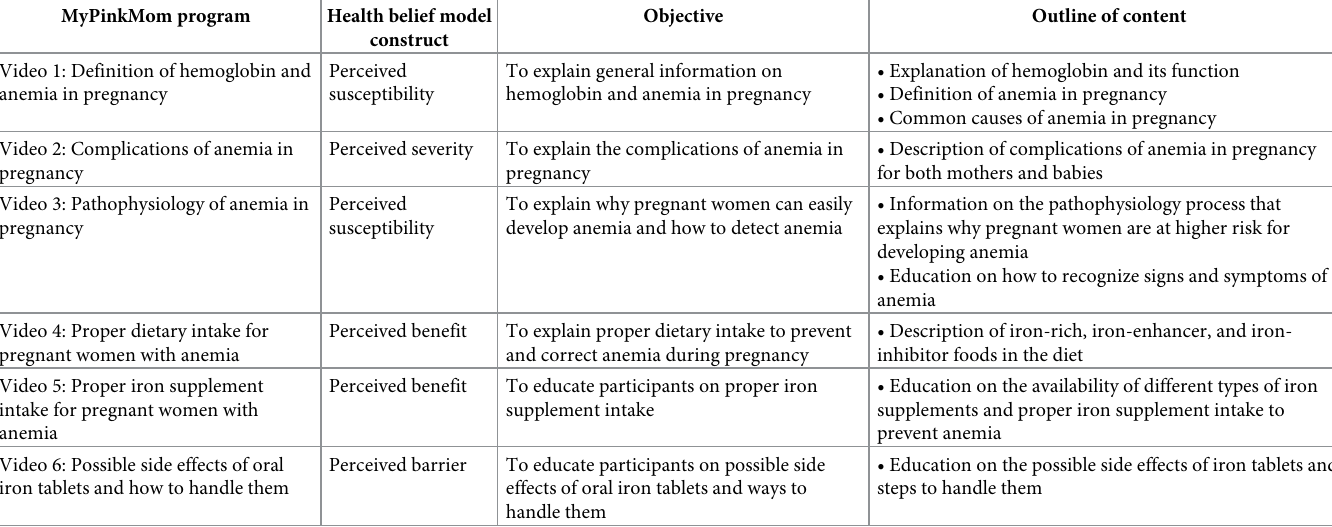
Table 1. Health belief model constructs, objectives, and outlines of content for the MyPinkMom